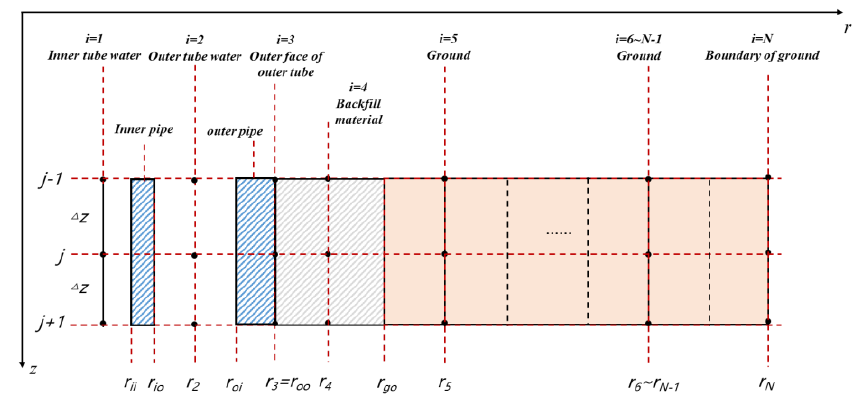
Figure 4. Discretization meshes of DBHEs and